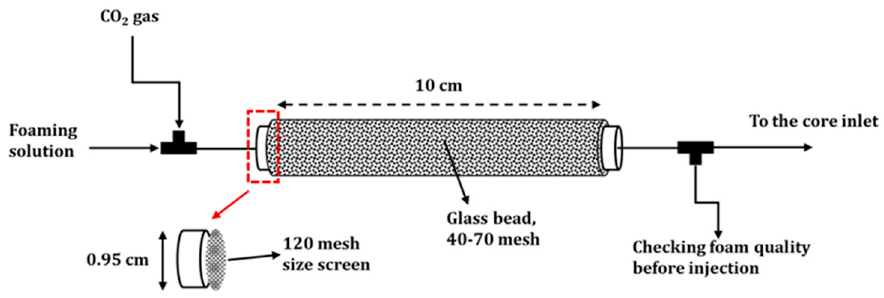
Figure 2. Schematic of the foam generator used for pre-generated foam/PEF (polymer enhanced foam) injection.